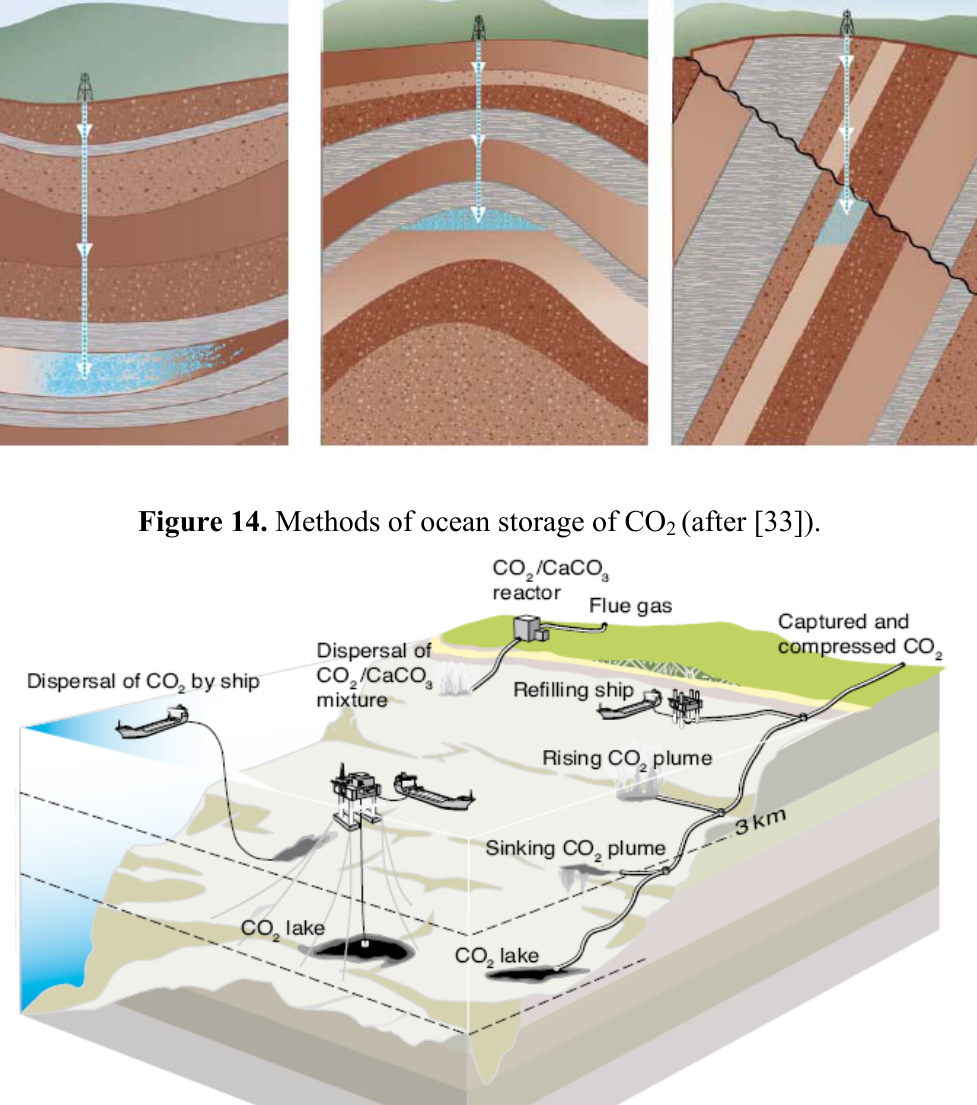
Figure 13. Stratigraphic (left) and structural (middle and right) trapping (after [69]). © 2008 IEA/OECD, reproduced with permission from Geologic Storage of Carbon Dioxide - Staying Safely Underground, p. 7.